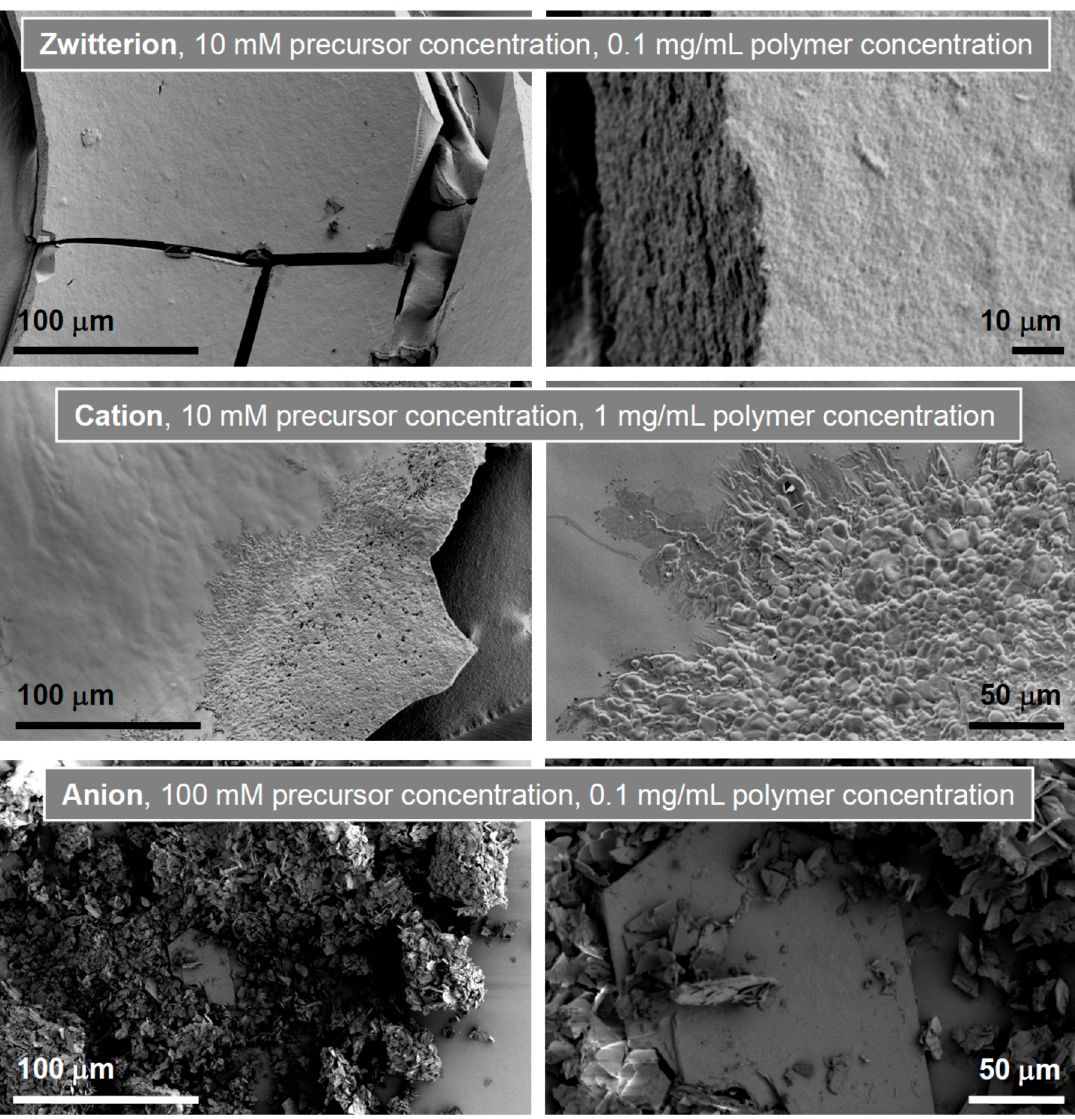
Figure 1. Representative SEM images of sample grown under different reaction conditions. Note that some of the samples showed very high charging (in spite of carbon or gold coating) and could therefore not be imaged with publishable image quality (see experimental part for details). Live observation in the SEM however shows that the samples look identical to those made under analogous synthesis conditions. Images in middle row show the “blob-” or “droplet-like” features mentioned in the text.